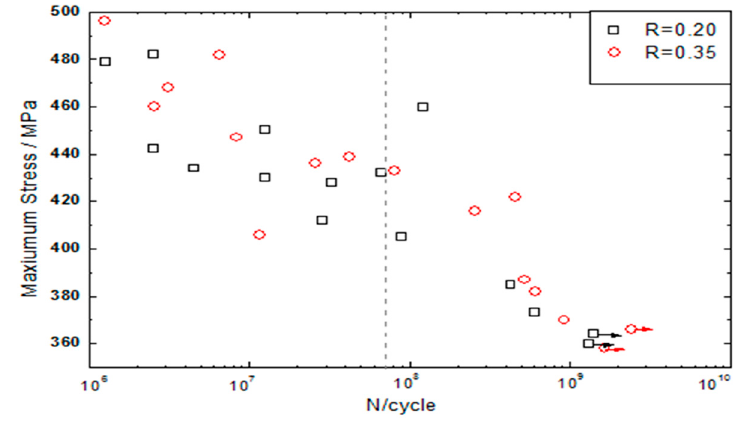
Figure 7. S–N curve for the CFRP specimen.